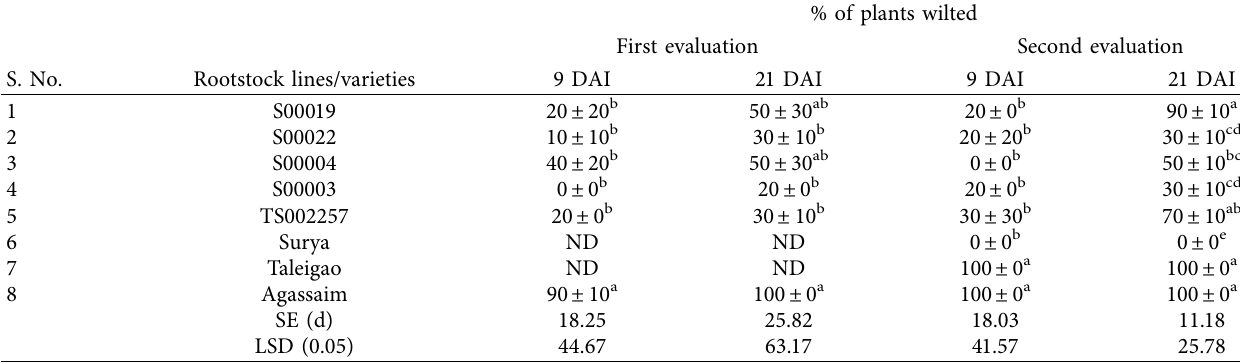
% of plants wilted First evaluation Second evaluation